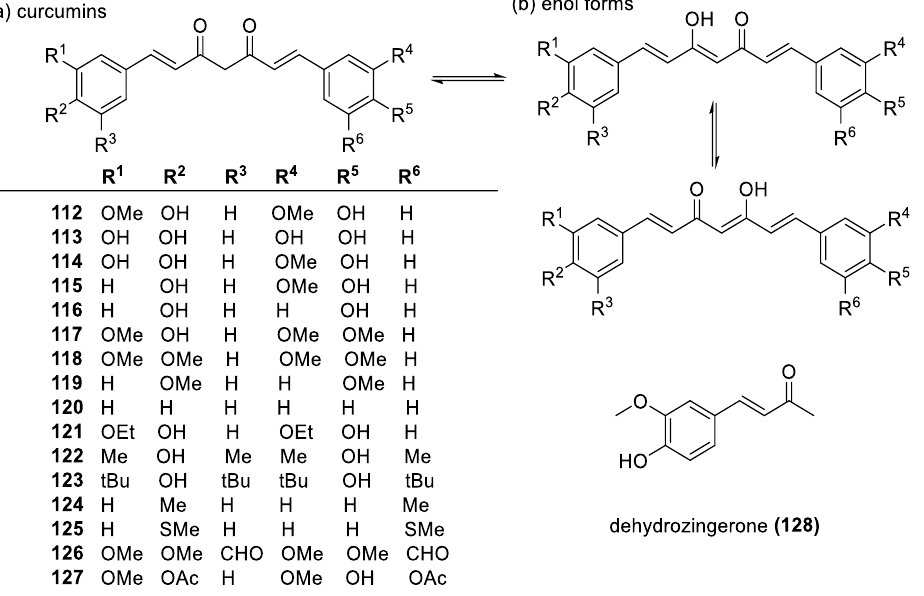
Figure 8. The structure of selected curcumin-based antioxidants.